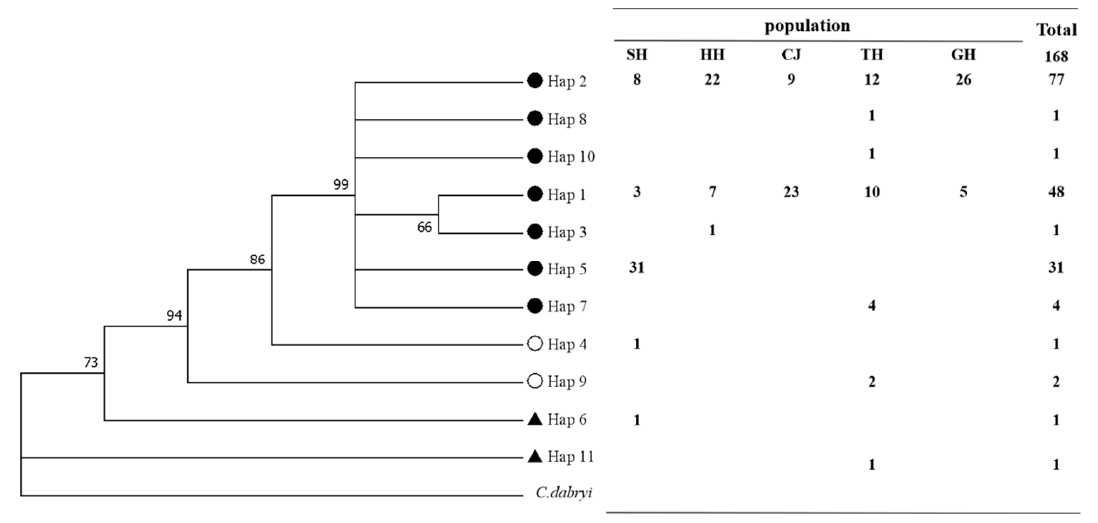
Figure 2. Distribution of 11 haplotypes in 5 populations and the ML tree. Note: the same symbol before haplotypes indicates clustering as a group.